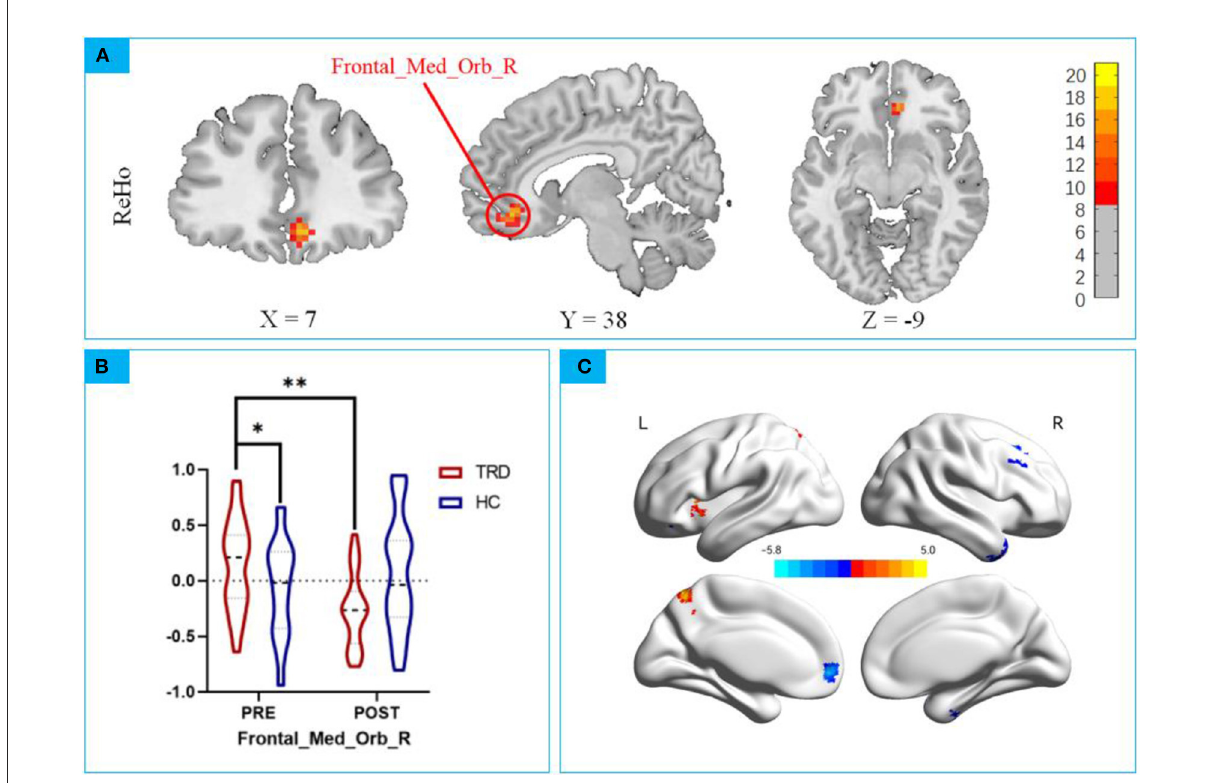
FIGURE3 (A) Significant group × stimulation interactions on ReHo were observed in the right medial orbital frontal cortex; (B) post hoc analysis showed taVNS decreased lower activation in the TRD group than baseline. * p < 0.01; ** p < 0.001 . (C) Main Effect of Time on ReHo. Blue colors represent decreased ReHo in after taVNS stimulation compared to before, while the hot colors represent the